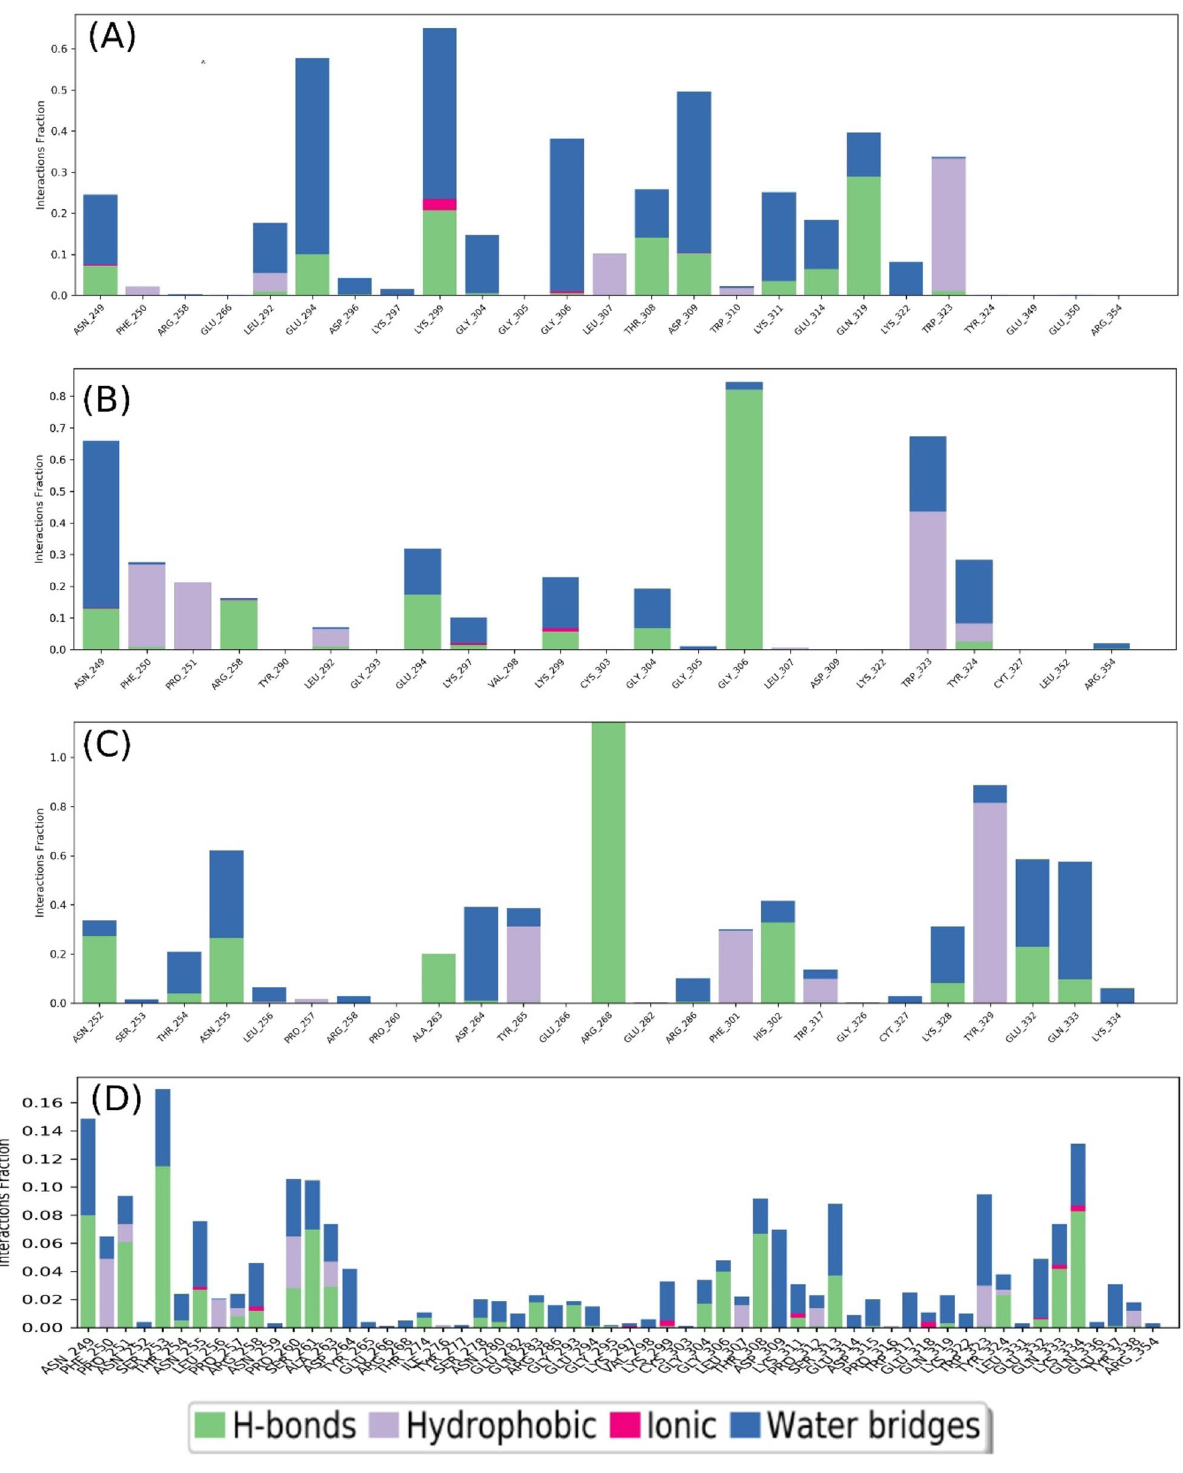
Figure 11. Protein–ligand contact mapping for XIAP with potential natural compounds, i.e. ( A ) ZINC77257307, ( B ) ZINC1070004335, ( C ) ZINC247950187, and ( D ) ZINC107434573 extracted from 50 ns MD